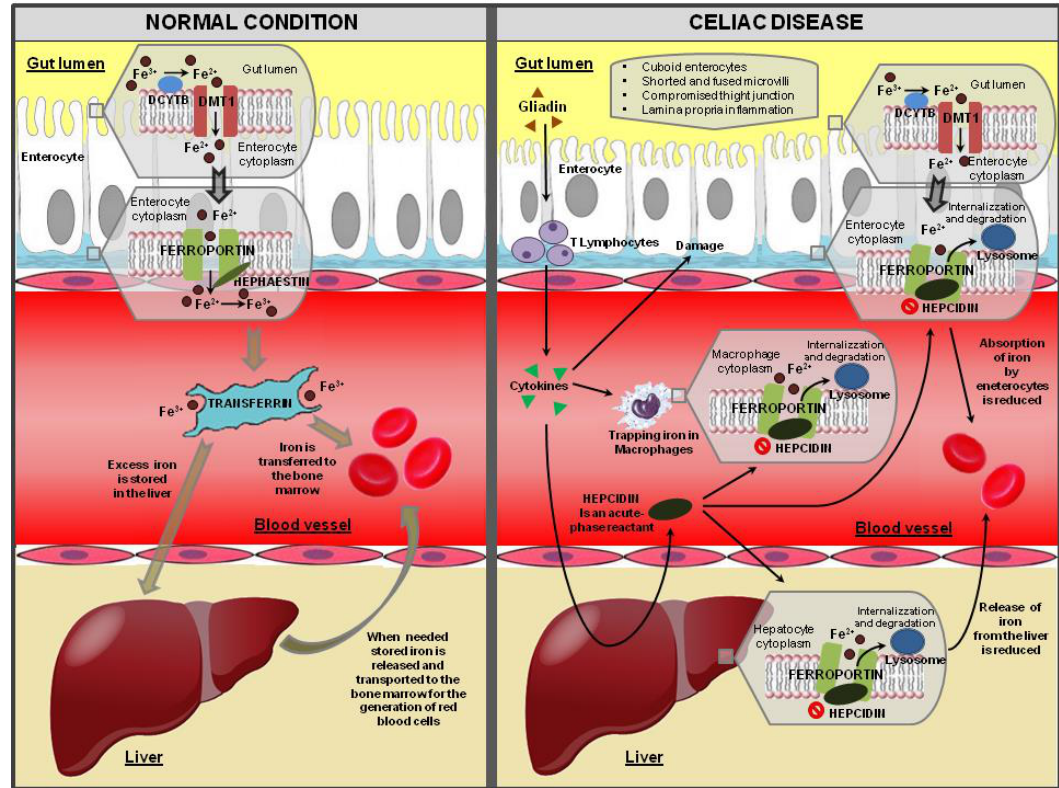
Figure 3. Mechanisms of iron deficiency anemia in celiac disease.In normal conditions, iron is absorbed in the gastrointestinal tract and then delivered to transferrin for transport to developing red cells; excess iron is stored in hepatocytes. In celiac disease, due to the atrophy of the intestinal mucosa, there is a reduced intestinal absorption of iron and therefore reduced iron delivery to developing red cells. Furthermore, the concomitant inflammation of the mucosa induced by gluten causes the increased release of cytokines, which can induce increased hepatic hepcidin production; hepcidin inhibits ferroportin, the main iron-export protein, and it consequently reduces iron release from enterocytes, hepatocytes, and circulating macrophages. DMT1: divalent metal transporter 1; DCYTB: duodenal cytochrome B. Adapted from DeLoughery et al. [55].